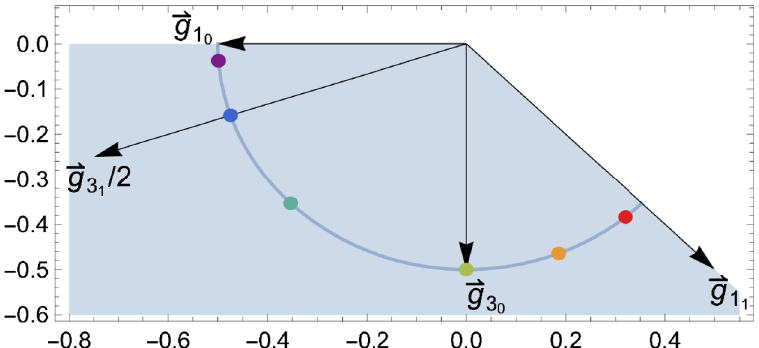
Figure 8. Positivity cone for SM left-handed lepton doublets. Generators are shown in black arrows. Solution spaces for w at the colored dots are further shown in figure α